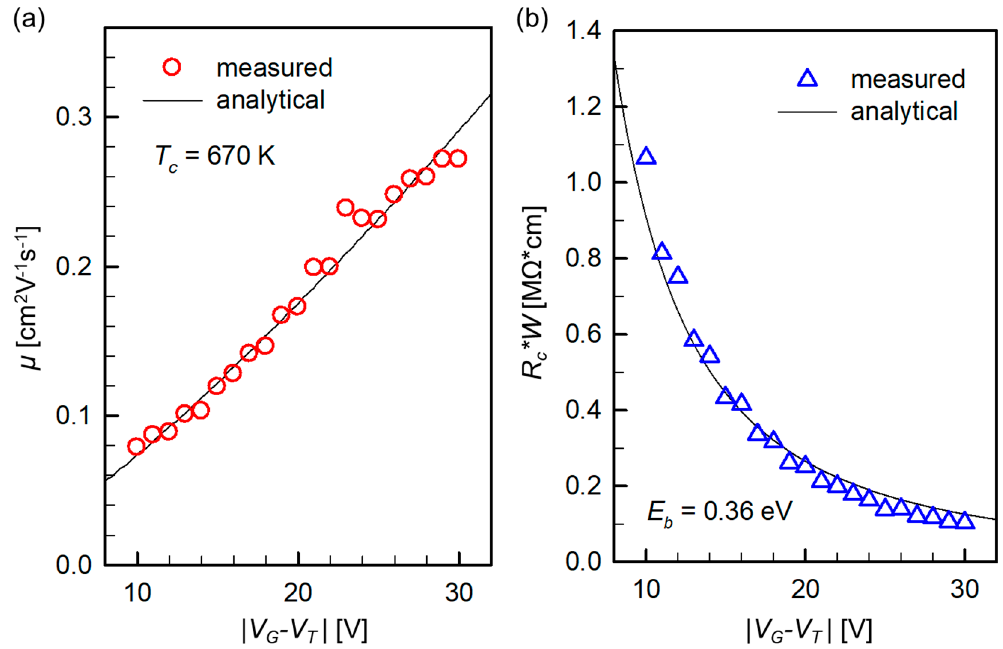
Figure 3. ( a ) V G -dependent μ in experimental devices overlaid with an analytical power-law mobility model. ( b ) Comparison between an experimentally measured and the model-produced R c versus V G trend, leading to an estimation of E b .